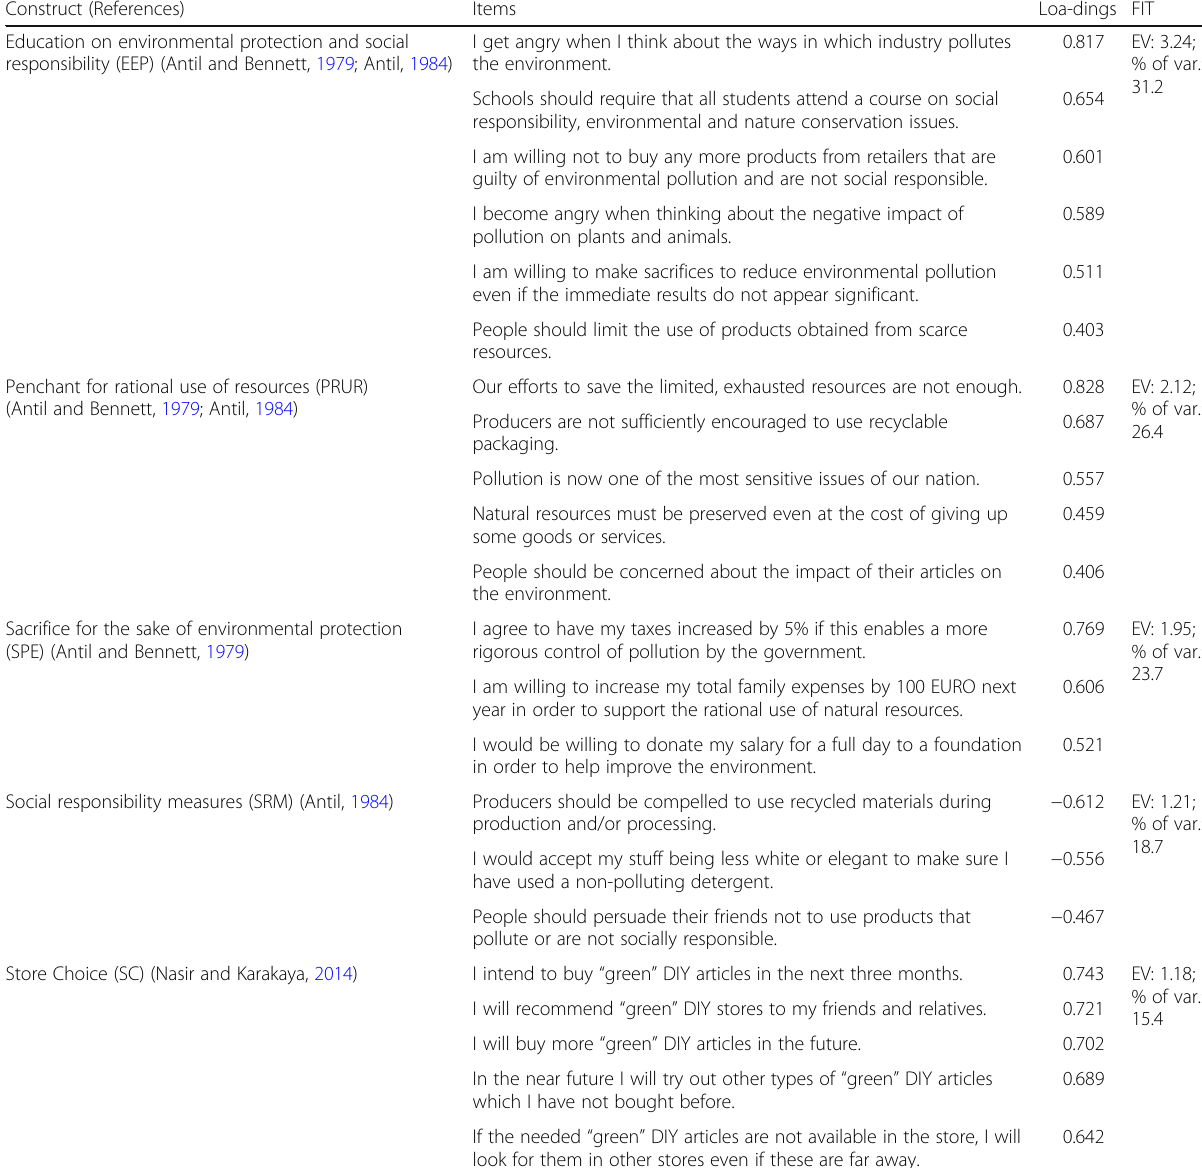
Table 2 Factor analysis of the investigated dimensions Construct